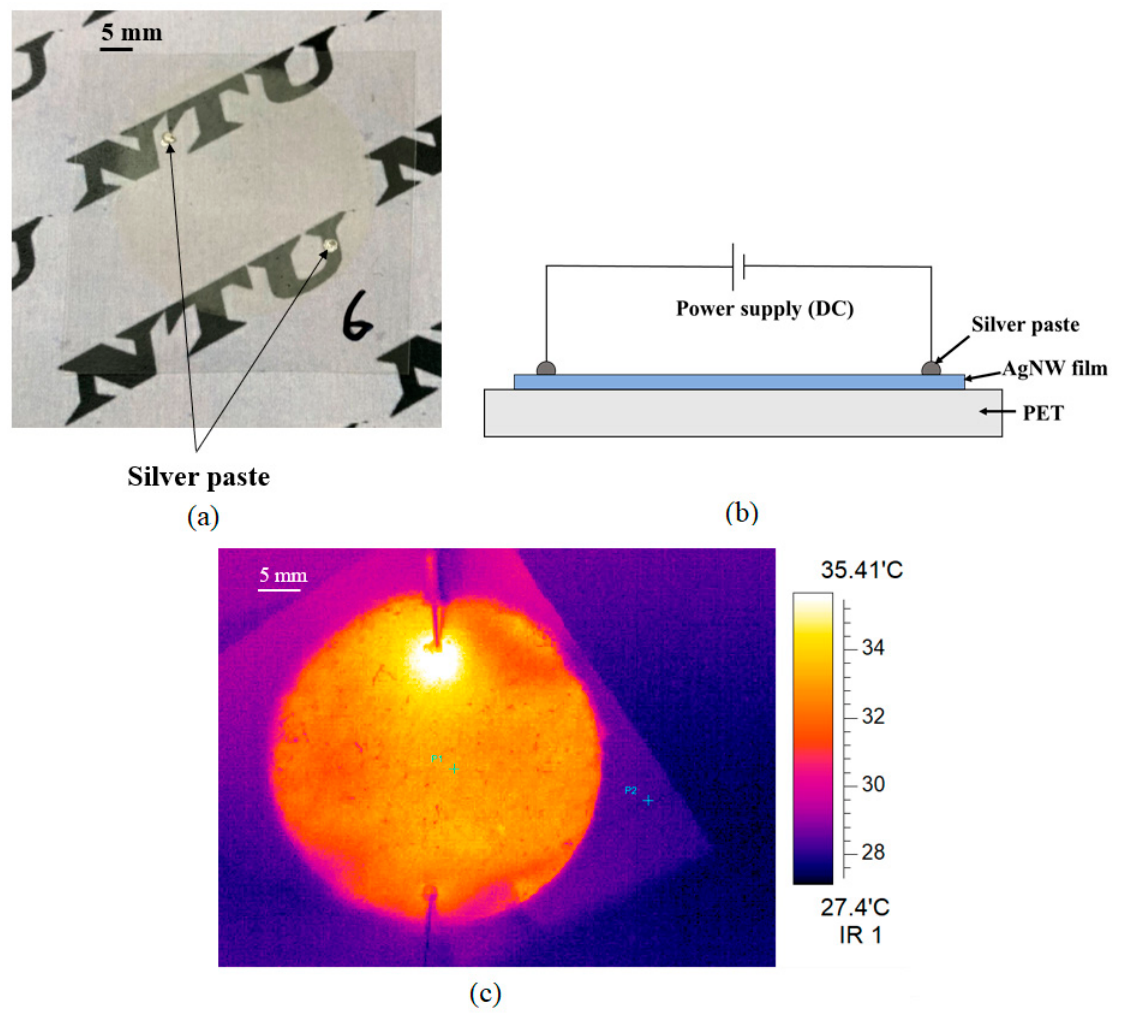
Figure 10. Resistive heater built with CW laser nanowelded AgNW films. ( a ) AgNW film (circle) on PET substrate (square); ( b ) schematic diagram of the measurement setup; ( c ) infrared picture of AgNW film under 5 V